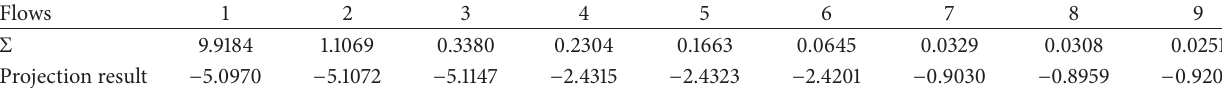
Table 2: The values of the diagonal matrix and the final result after projection.